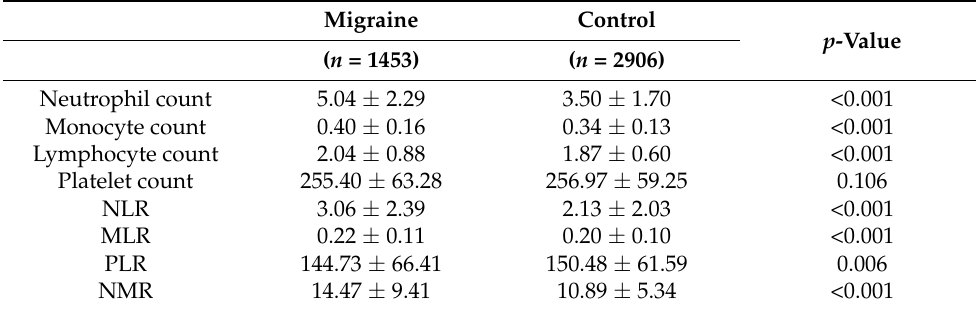
Table 4. Peripheral inflammatory markers of the migraine and control groups after